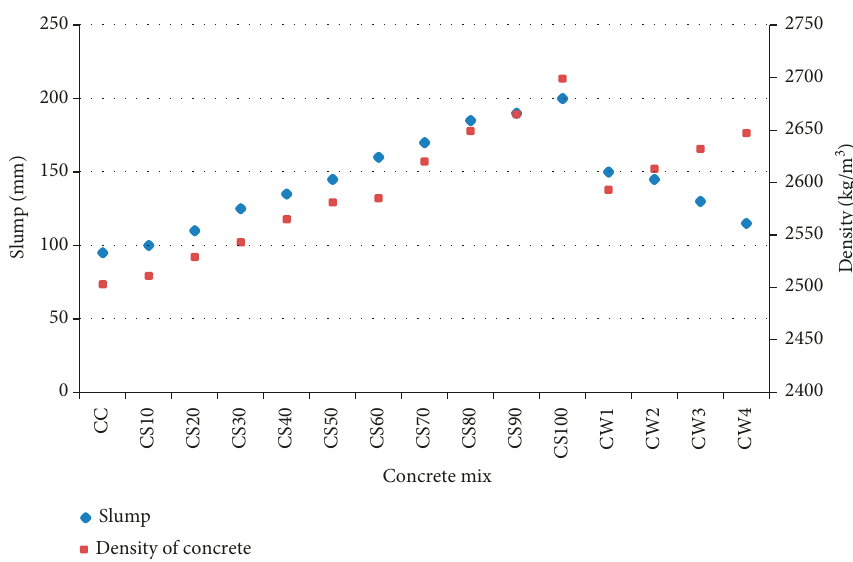
Figure 1: Slump of fresh concrete and 28 days’ density of concrete